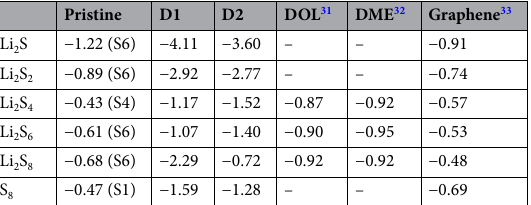
Table 1. Binding energies (in eV) of LiPSs and S 8 clusters with pristine BPN (favorable adsorption site), defective BPN sheet, DOL, DME, and graphene.